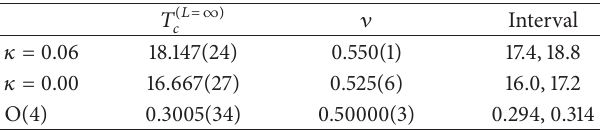
Table 3: Curve collapse results of Binder’s cumulant where the last column indicates the interval of the control parameter in which the procedure has been used. The parameter 𝑇 stands either for 𝑦 in the Higgs-Yukawa model or for 𝜅 in the O(4) model. All errors are statistical